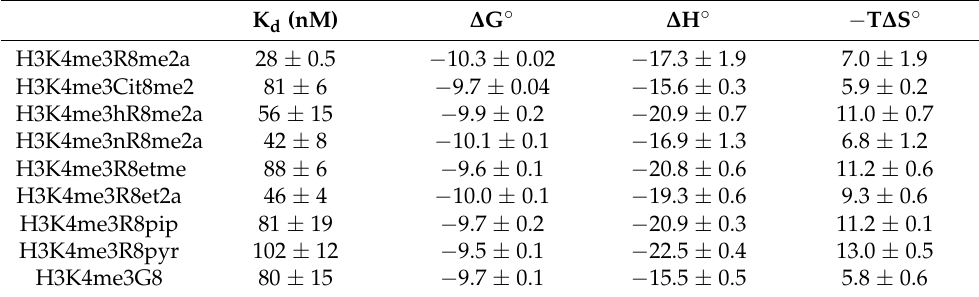
Table 1. Thermodynamic parameters for the binding of the 15-mer H3K4me3X8 peptides to Spindlin1. Data are mean ± SD, n = 0.98–1.08, T = 25.0 ◦ C, values obtained from 3 repeated ITC